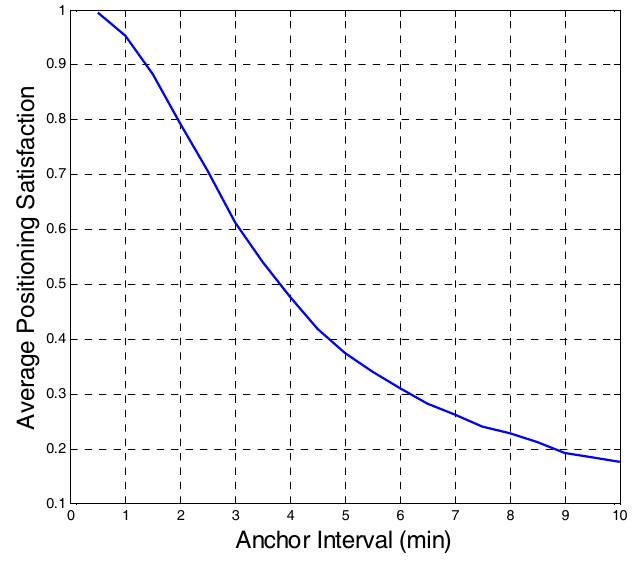
Figure 5. Average satisfaction with different anchor intervals.